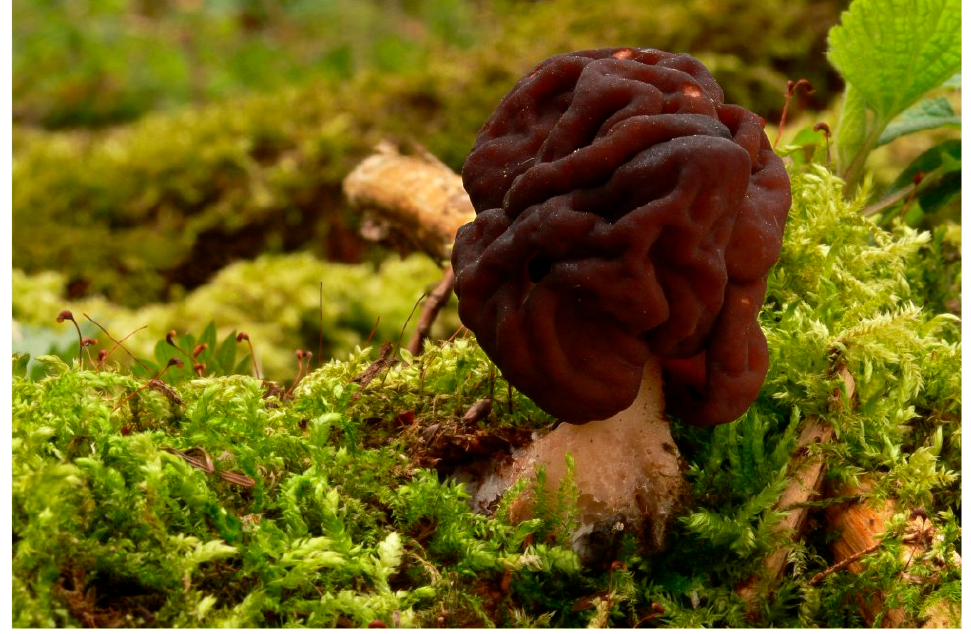
Figure 11. Gyromitra esculenta [218].